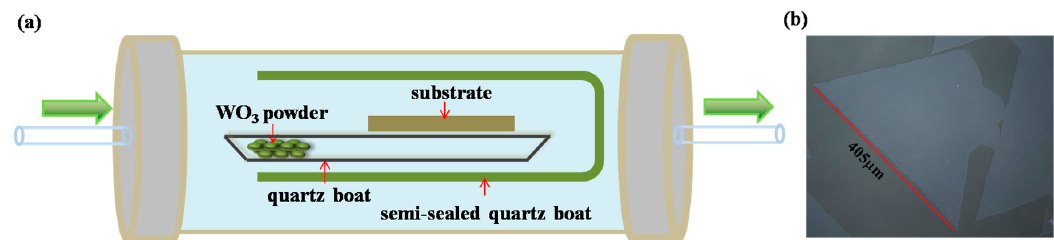
Figure 2. ( a ) Semi-sealed equipment schematic diagram; ( b ) optical microscope of 405µm monolayer WS 2 film.